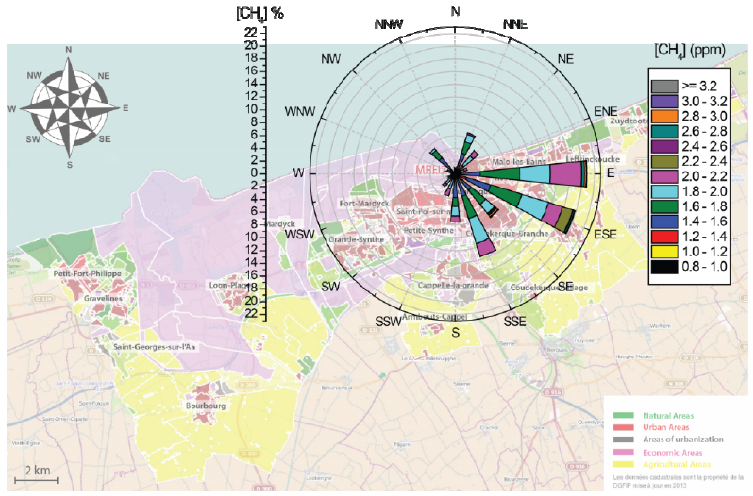
Figure 13. Frequency distribution rose of CH 4 concentrations depending on the blowing wind sectors from 9th to 22nd of January 2013 in Dunkirk.